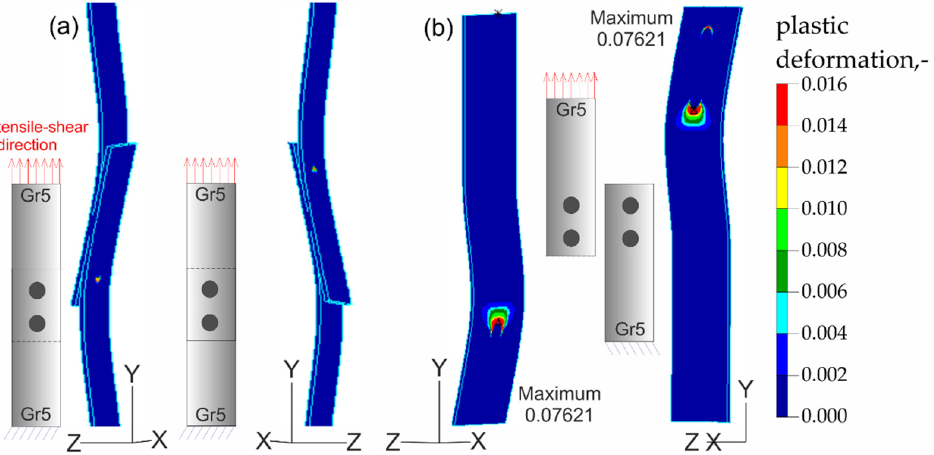
Figure 20. Distribution of plastic deformations in the Gr5–Gr5-2 joints: ( a ) on the surface of the entire joint and ( b ) on the inner surfaces of the joints.